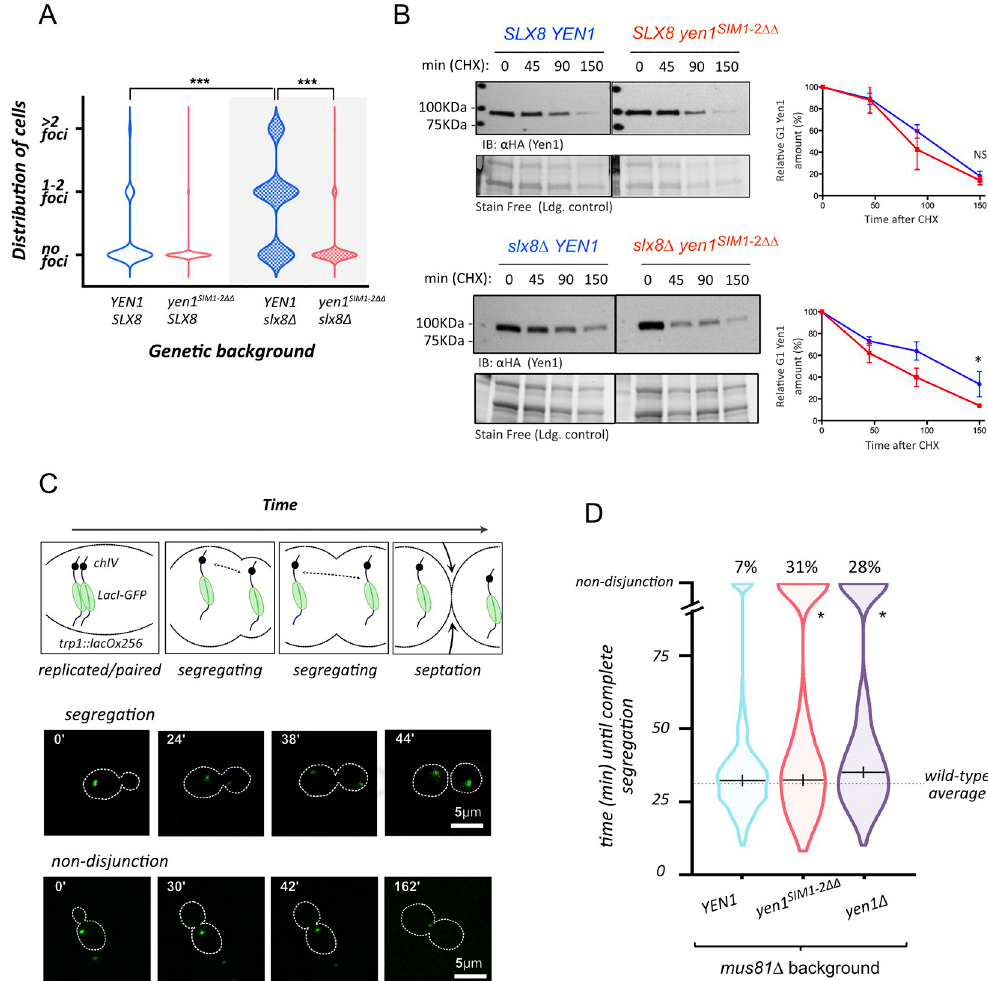
Fig 5. Mutation in the SIMs of Yen1 prevents foci accumulation in slx8 Δ cells during G2/M and impacts chromosome segregation in a mus81 Δ background. (A) Cells containing a deletion of SLX8 were observed for their distribution of foci of the different variants of Yen1-GFP. Violin plots display the distribution of cells and asterisks denote statistical significance in a Chi-square test at P < 0.0001 ( ��� ), see S8 Table. (B) Cells from the indicated genotypes were arrested in G1 and released in the presence of cycloheximide with samples being taken at the indicated time points. Total protein extracts were inspected by immunoblot for the presence of Yen1-HA and their intensity quantified relative to the loading control obtained by stain-free imaging of the gels (BioRad). Relative amounts of Yen1 are plotted in the graph to facilitate comparison (+/- SD). (C) Diagram showing chromosome segregation in cells harboring a lacO/GFP-LacI array tag on chromosome VII. To discriminate cells with timely chromosome segregation from those presenting aberrant segregation (delayed segregation or non-disjunction) a 2 hrs limit of observation was implemented. Two sets of representative actual images of a normal segregation pattern and a non-disjunction pattern are shown below the diagram. (D) Over 400 cells per strain were individually counted and are represented in violin plots according to the time spent to segregate the lacO/lacI array. The median segregation time is indicated excluding cells with non-disjunctions. Statistical relevance of the differences observed between the number of non-disjunctions of the different strains was determined by the Chi-square test at P < 0.0001, see S9